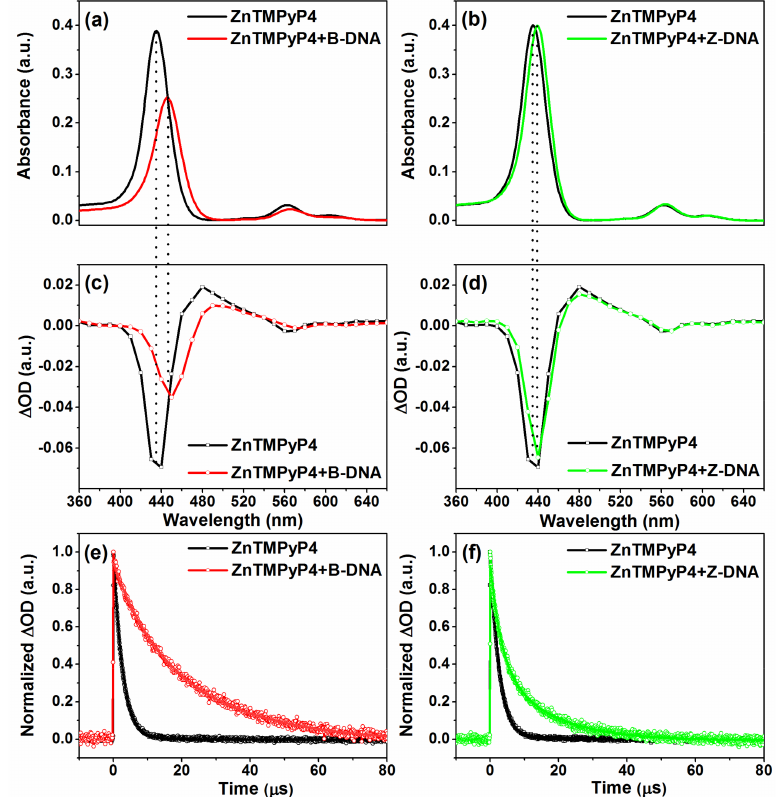
Figure 5. ( a , b ) Steady-state UV/Vis absorption spectra and ( c , d ) transient UV/Vis absorption spectra recorded instantly (50 ns) after laser flash photolysis upon 355 nm excitation for free ZnTMPyP4 (2 µ M) and its complexes with each of the two DNA (50 µ M)) in Na-cacodylate buffer (1 mM, pH = 7.0). Normalized triplet decay signals after laser flash photolysis of ZnTMPyP4 (2 µ M) upon 355 nm excitation in the absence (black) and presence of B-DNA (50 µ M) ( e ) and Z-DNA (50 µ M) ( f ). Fitted curves are shown by solid lines. The fits are all obtained from complete decay